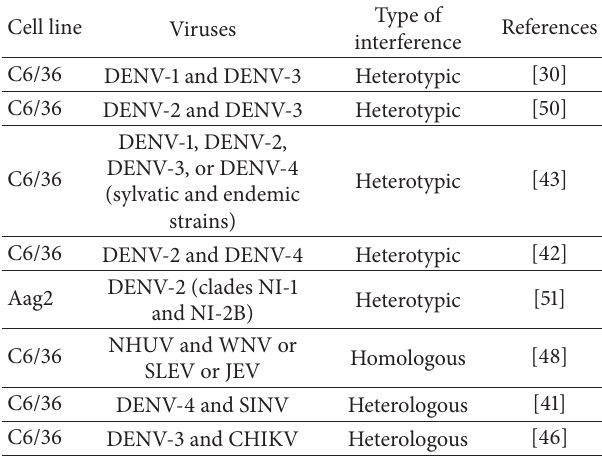
Table 3: Coinfections with flaviviruses in mosquito cell lines. Cell